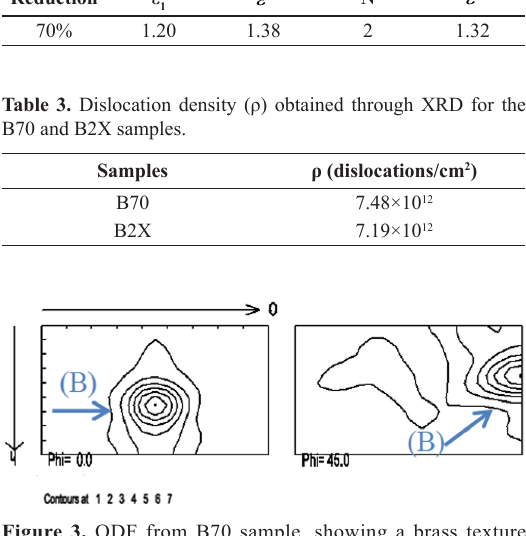
Figure 3. ODF from B70 sample, showing a brass texture component (B).